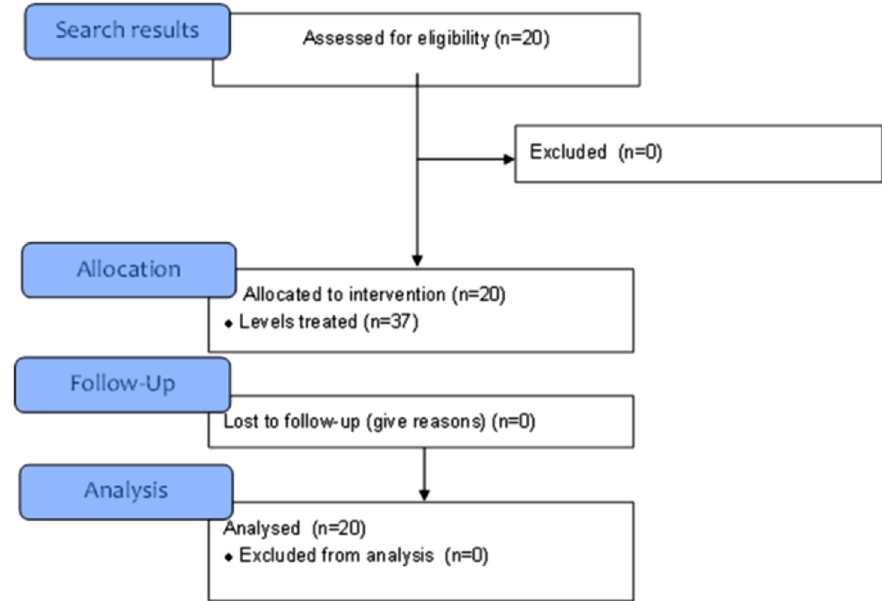
Figure 3. Inclusion fl ow